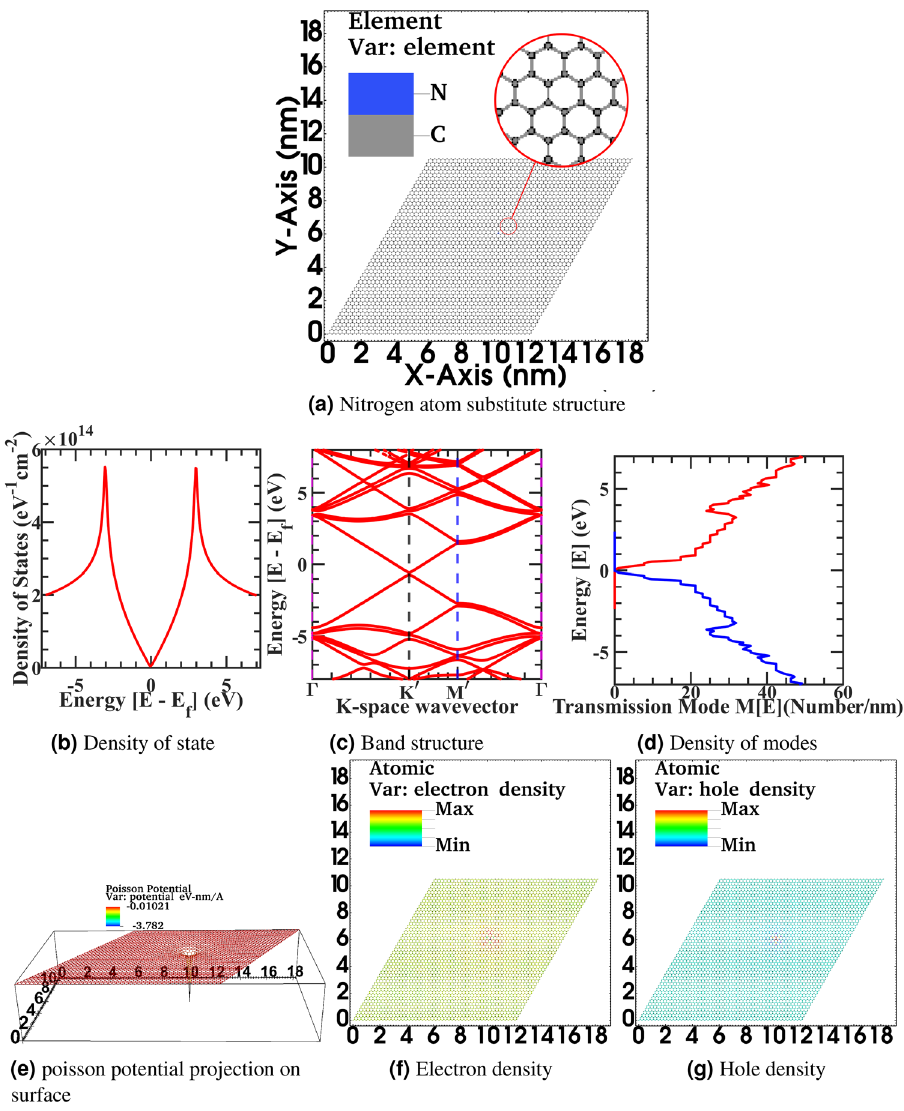
Figure 6. Primitive device structure 50 x 50 graphene supercell with substitutional Nitrogen impurity ( a ), Density of state ( b ), Electronic band structure ( c ), Density of modes ( d ), Self-consistent Poisson potential due to Nitrogen impurity projection on surface ( e ) Electronic density ( f ), Hole density ( g